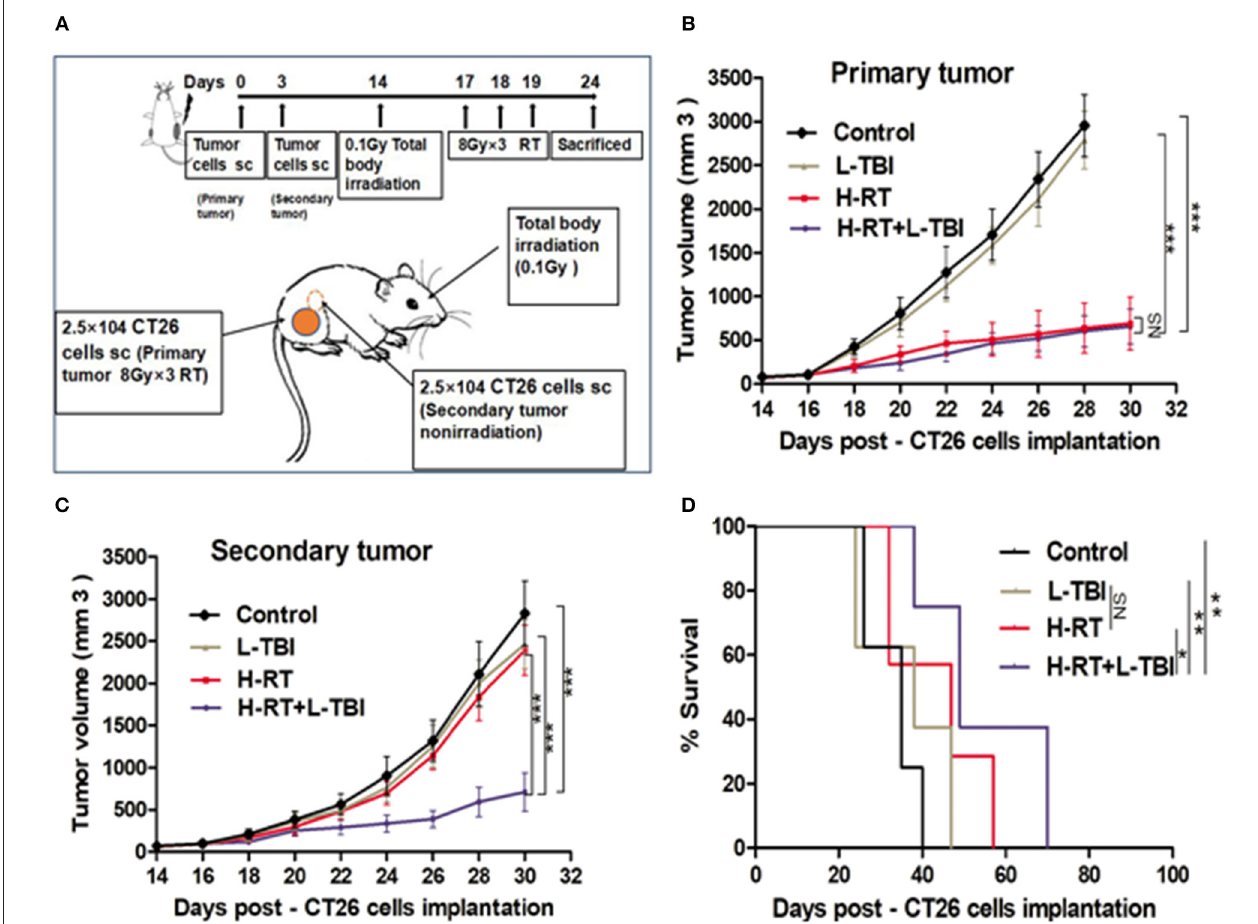
FIGURE 8 | Combination therapy of CT26 tumor with H-RT and L-TBI. (A) CT26-derived tumors model and treatment timeline. Immunocompetent mice were injected s.c. with syngeneic CT26 cells (2.5 × 10 4 ) into the right (primary tumor) and left (secondary tumor) flank, respectively. Only the primary tumor received H-RT ( n = 12 mice/group). CT26 tumor growth curves of primary irradiated tumors (B) and secondary non-irradiated tumors (C) between different groups ( n = 8 mice/group). (D) Overall survival curves of investigation groups ( n = 8 mice/group). (* P < 0.05, ** P < 0.01, *** P < 0.001, and NS = not